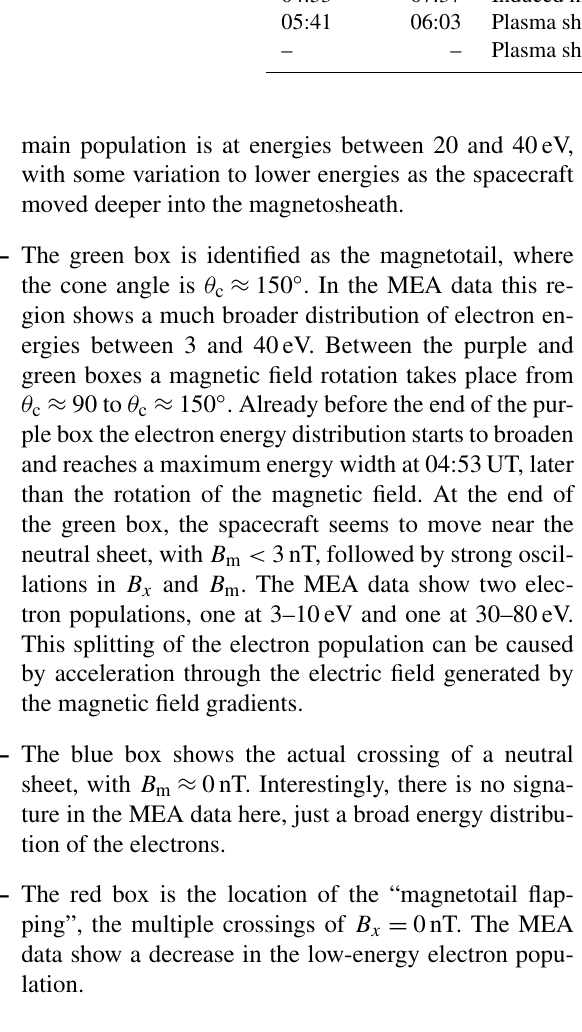
Table 4. A comparison of the boundary crossings determined from MEA and from MAG. There are two intervals for the plasma sheet for MAG, and the second corresponds to the flapping interval. MEA Crossing MAG Time in Time out into/out of